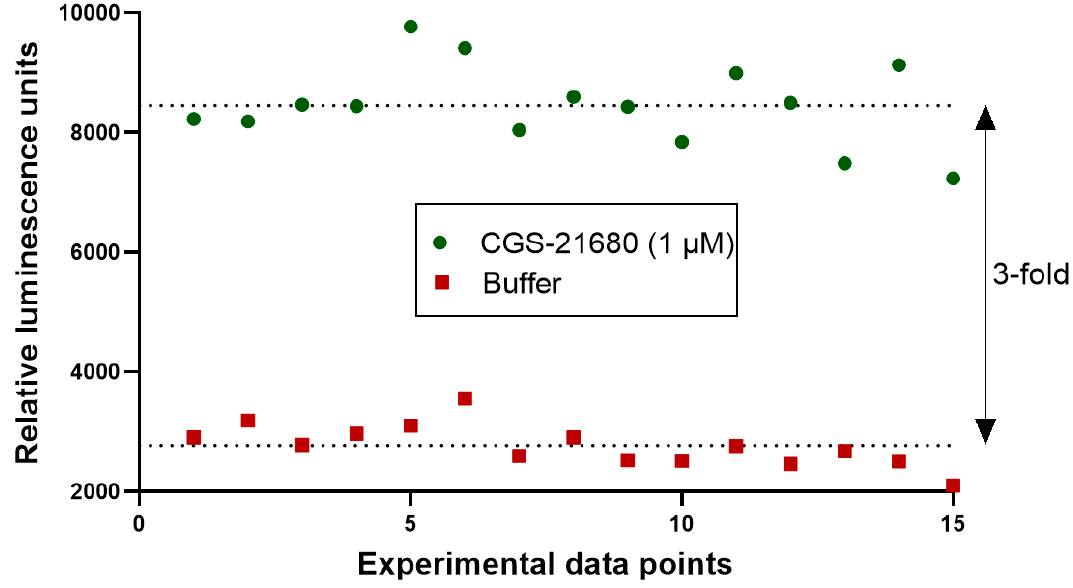
Figure 9. Evaluation of suitability of the newly developed Cx43 GJ assay for high-throughput screening (HTS). The quality of the assay was assessed by calculating the screening window coefficient (Z ´ -Factor) as previously described [31]. A coculture of donor cells (90,000 cells/well) and biosensor cells (30,000 cells/well) at a ratio of 3:1 was incubated in assay buffer for 45 min. Prior to the addition of the A 2A AR agonist CGS-21680 (1 µ M) to the coculture, basal luminescence was measured (red data points, negative control). The coculture was then activated by the addition of CGS-21680 (1 µ M). The luminescence signal had reached a stable plateau 19 min after stimulation, and data points were measured as positive controls (green data points). We measured 15 separate data points for positive and negative controls, indicating reproducibility and an assay window of about 3 ‐ fold.